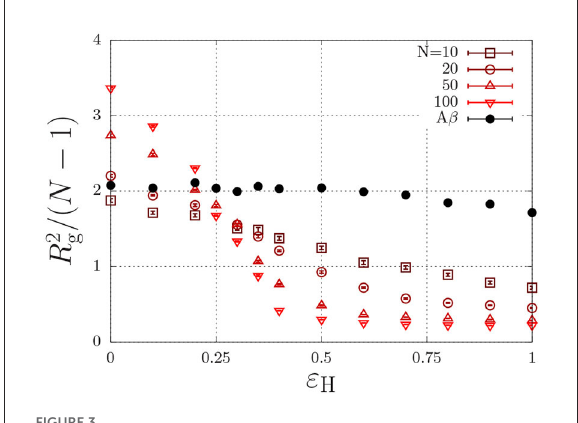
FIGURE3 1), ( R g is the radius of gyration in units of Polymer size, R 2 g / ( N − the lattice spacing) as a function of the hydrophobic interaction energy ε H / k B T for a various number of beads per chain, N . The A β model has a total of N 20 beads, of which 7 are =